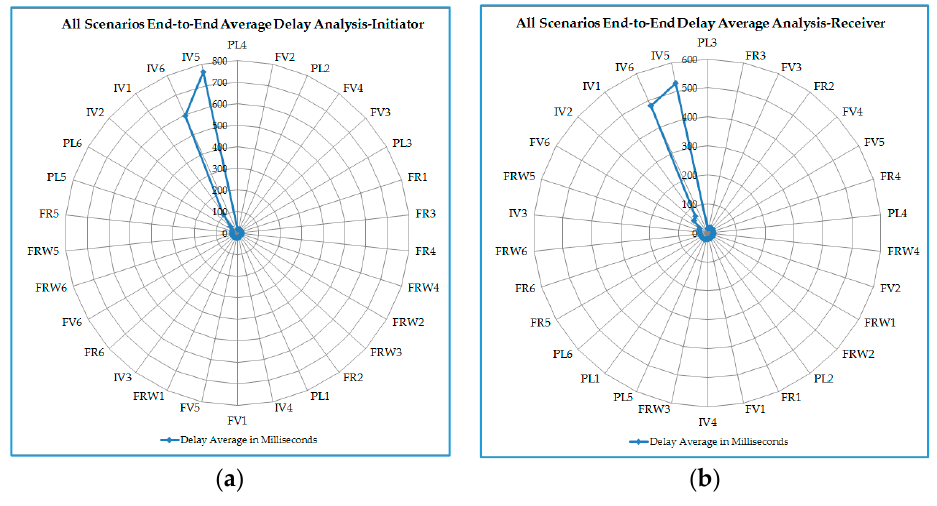
Figure 15. All scenarios’ MOS values comparison for: ( a ) VoIP initiators; ( b ) VoIP receivers.